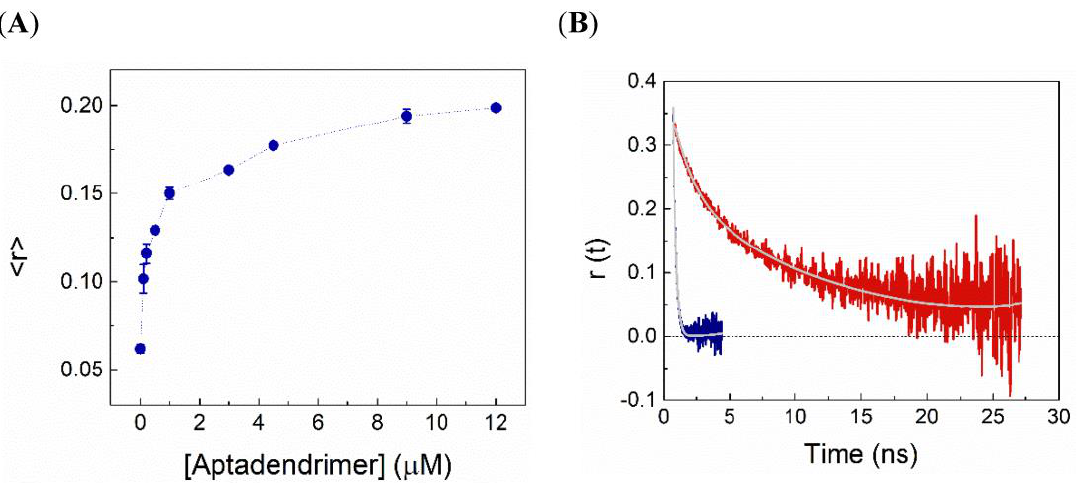
Figure 5. C 8 binding to the aptadendrimer. ( A ) Changes in the steady-state fluorescence anisotropy of 0.5 µM C 8 with increasing aptadendrimer concentrations. ( B ) Fluorescence anisotropy decays of 0.5 µM C 8 in buffer (blue) and in the presence of 9 µM of aptadendrimer (red). The rotational correlation times increased upon complexation denoting the changes in the segmental motion of bound C 8 ( 𝜙 1 from ~0.01 to 1.5 ns) and it is slower global tumbling upon binding to the large dendrimers ( 𝜙 2 increased from 0.15 to 10 – 12 ns).